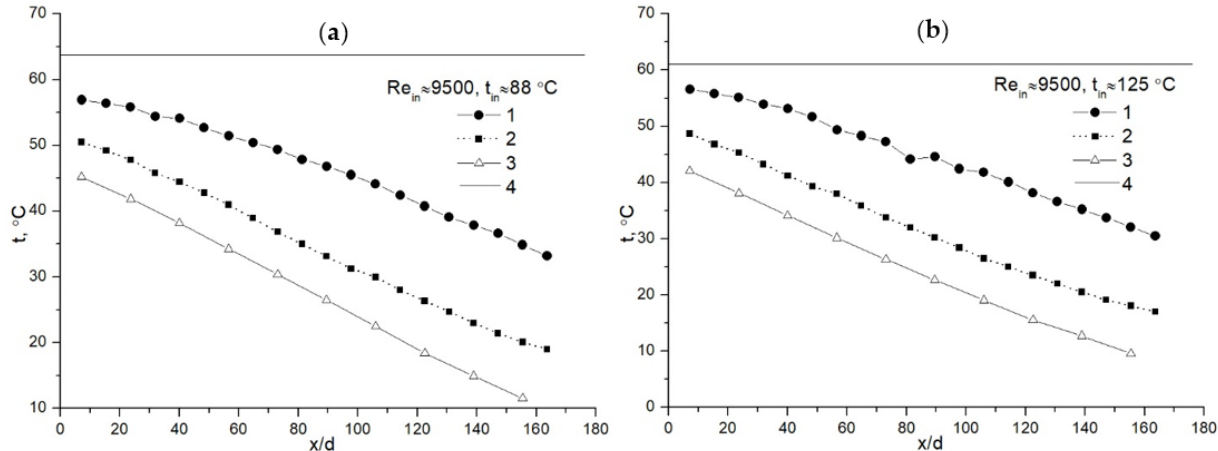
Figure 6. Temperature distribution along the model of the condensing heat exchanger at Re in ≈ 9500, different flue gas inlet temperatures ( a ) t in ≈ 88 °C, ( b ) t in ≈ 125 °C and water injection of 40 °C: (1) center of the calorimetric tube, (2) the inner wall of the calorimetric tube, (3) cooling water in the middle of the inner and the outer tubes, (4) dew point temperature at the inlet to the calorimetric tube.